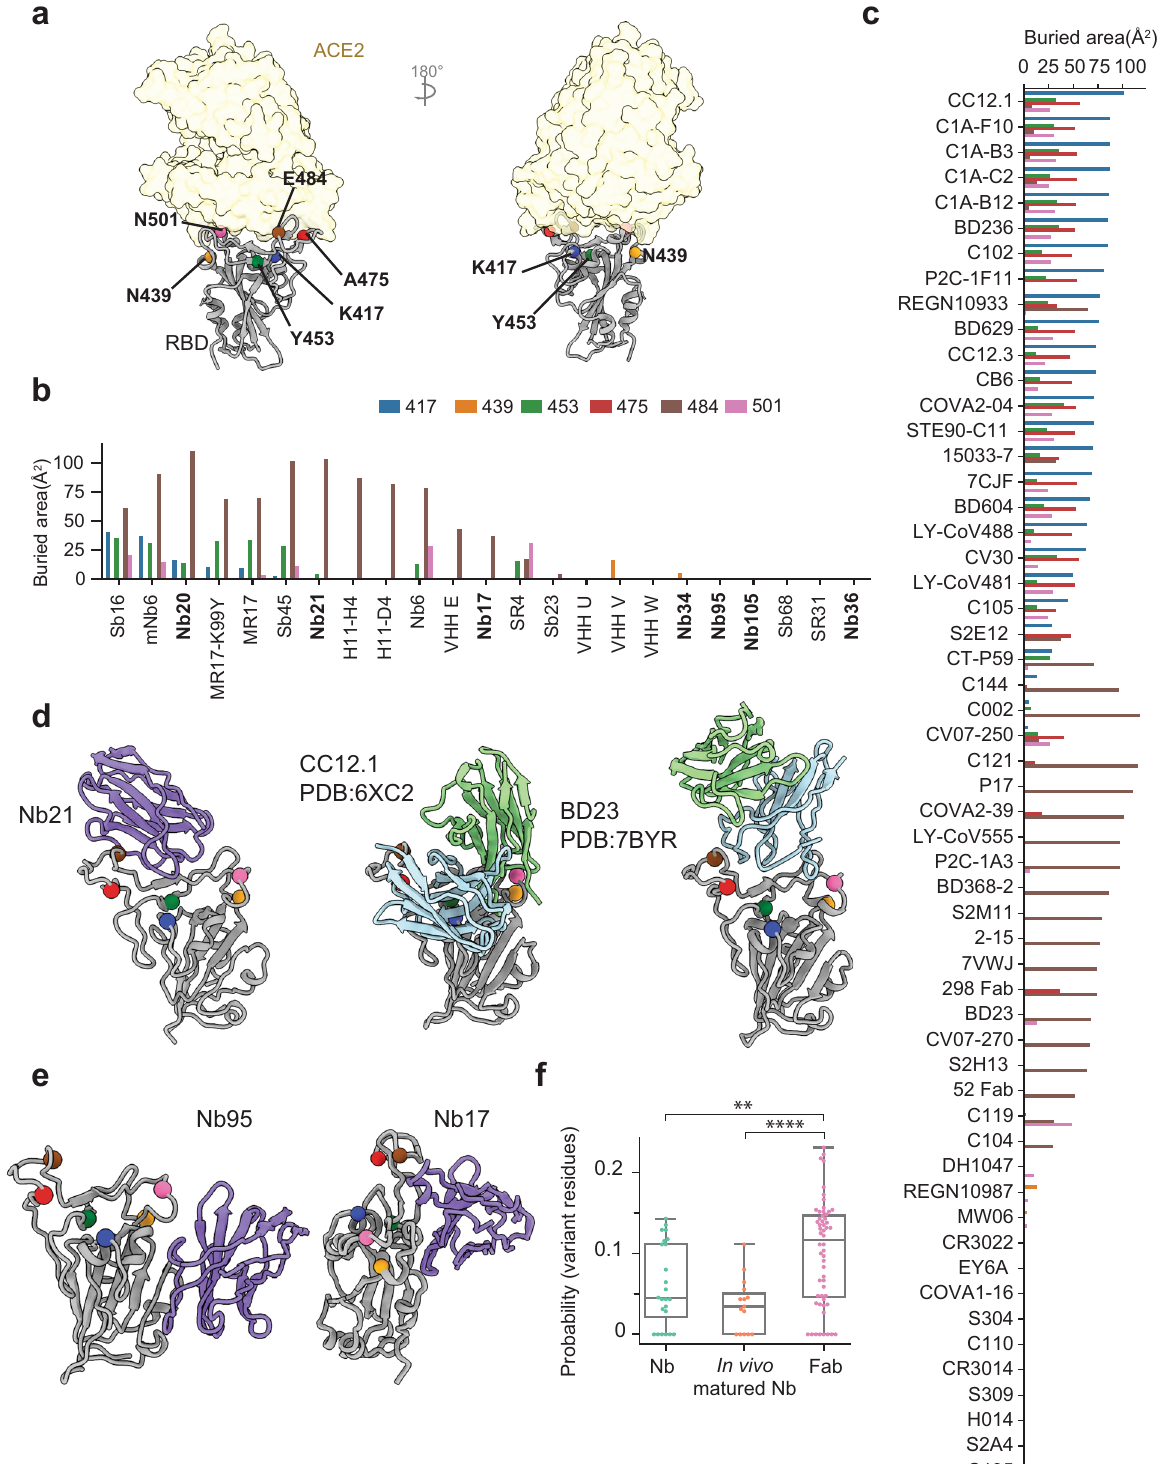
Fig. 6 mAbs and Nbs binding to RBD are differently affected by mutations in the circulating variants. a Localization of six RBD residues where major circulating variants mutate. b Buried surface area of Nbs by different RBD residues. c Buried surface area of Fabs by different RBD residues. d , e Representative structures of different classes of Nbs with major variant residues shown as spheres. Two Fab structures that bind similarly to Class I Nbs were shown on the side. f The boxplot showing the probability of epitope residues coinciding with the variant mutations ( n = 24, 15, and 56 for Nbs, in vivo matured Nbs, and Fabs, respectively). Box plots indicate median (middle line), 25th, 75th percentile (box), and 5th and 95th percentile (whiskers) as well as outliers (single points). Statistical analysis was performed using a two-tailed student t test, * p < 0.05, ** p < 0.01, *** p < 0.001, **** p <